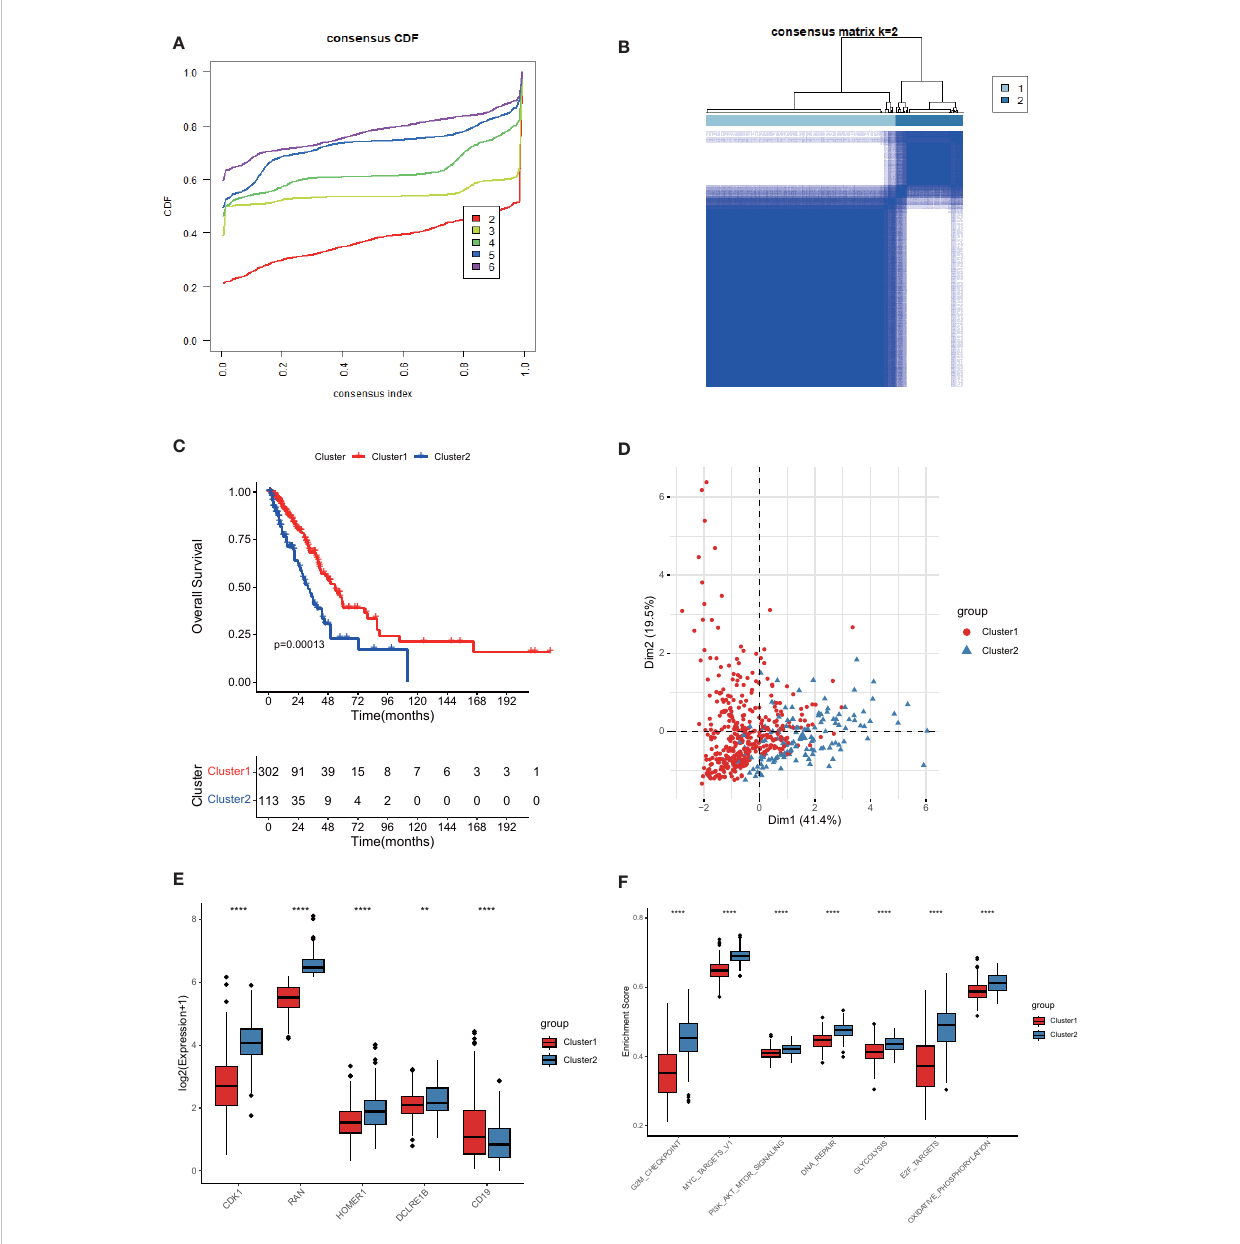
FIGURE 3 Subtype classi fi cation based on 5 prognostic T cell proliferation-related regulator genes (TPRGs) and enrichment analysis. (A) Consensus clusters by TPRGs. (B) Clustering heatmap. Consensus matrix at optimal k = 2. GCTA-LUAD patients were classi fi ed into clusters 1 and 2. (C) Overall survival analysis for the clusters 1 and 2. (D) PCA analysis. (E) Expression of fi ve risk-related TPRGs (including CDK1, RAN, HOMER1, DCLRE1B and CD19) in the two clusters. (F) Enrichment analysis of proto-oncogene carcinogenic pathways in the two clusters. ** P < 0.01 and **** P <